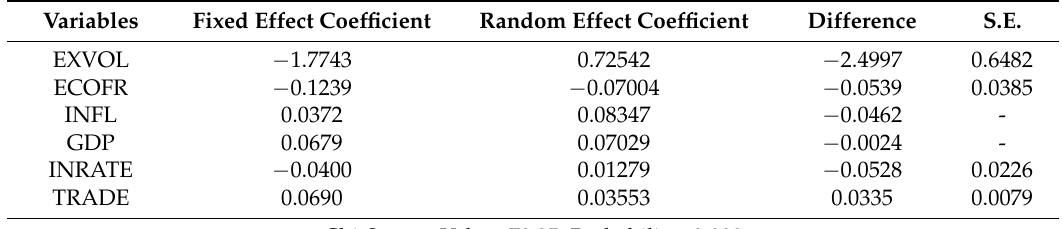
Table A10. Hausman Test: FDI and Exchange Rate Volatility (TGARCH).